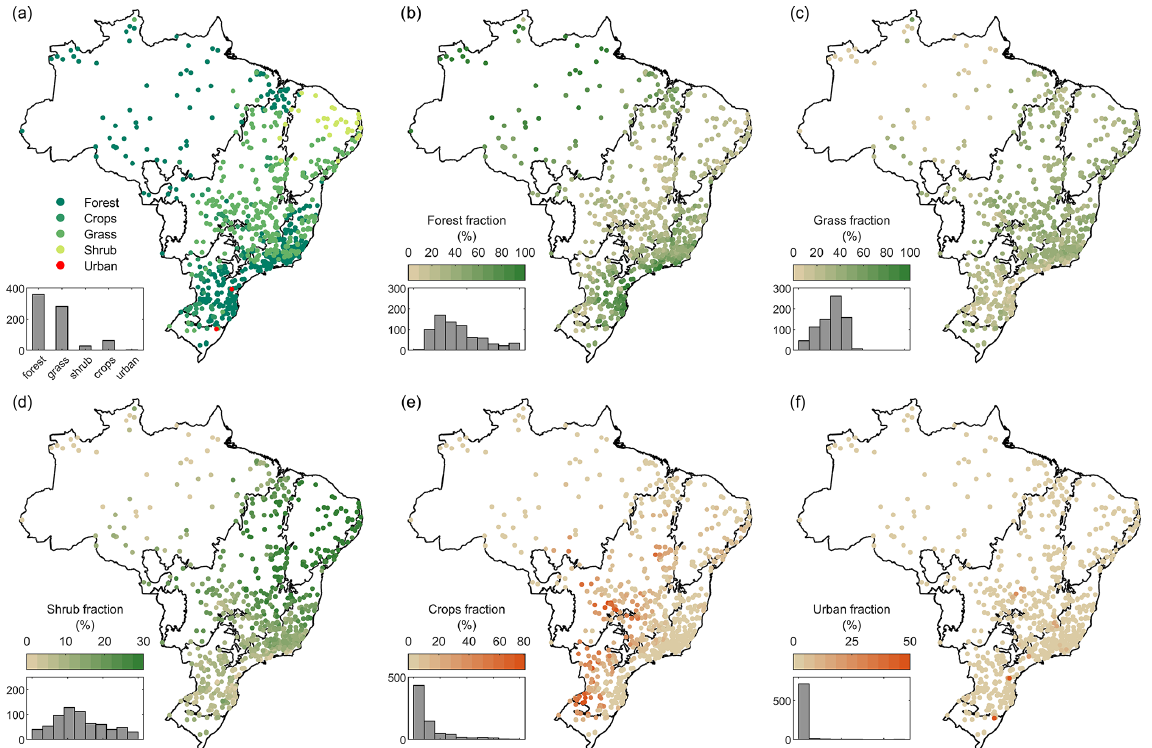
Figure 11. Spatial distribution of the land-cover and land-use attributes of the CABra catchments. (a) The most common land-cover type in the catchment; (b) forest fraction of land cover (in percent); (c) grass fraction of land cover (in percent); (d) shrub fraction of land cover (in percent); (e) crops fraction of land cover (in percent); (f) urban fraction of land cover (in